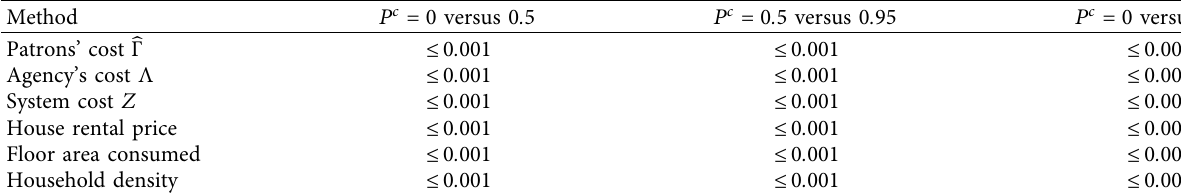
Table 4: P -value of t -tests.